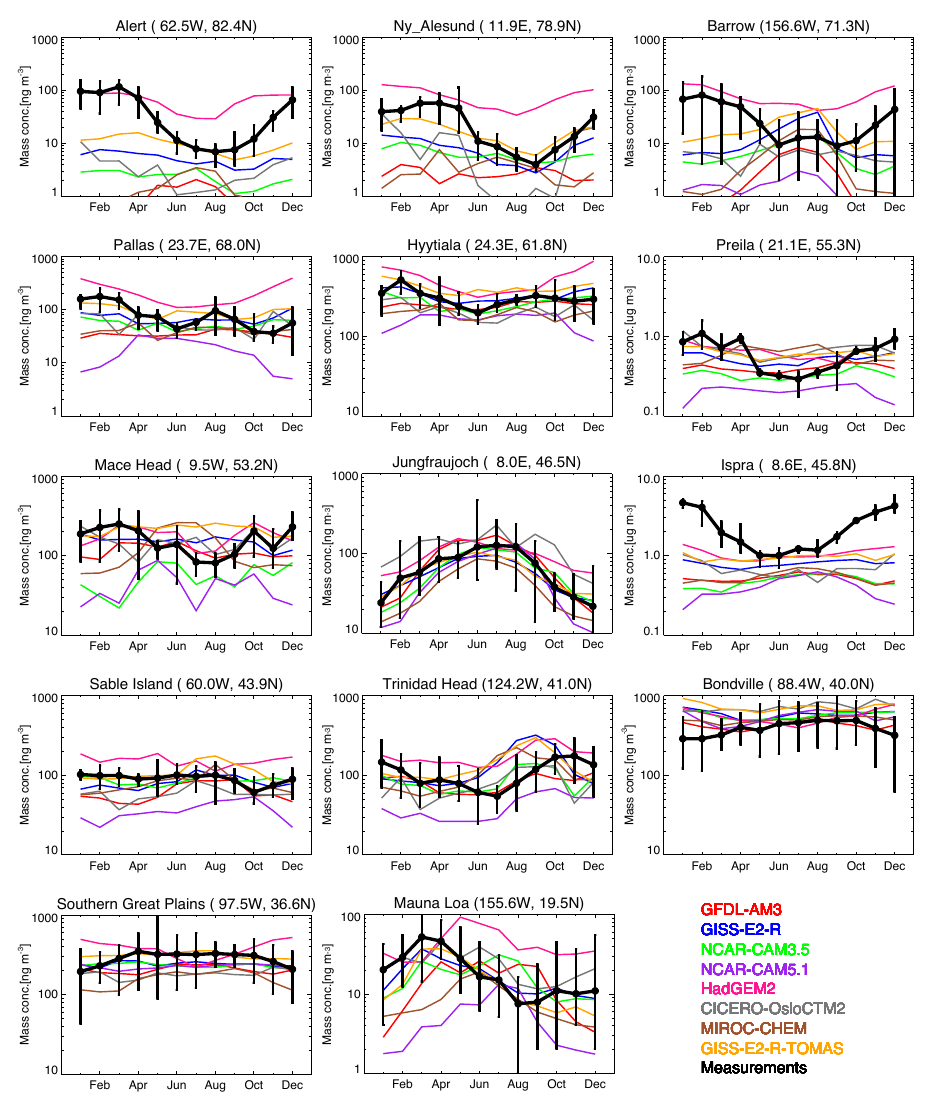
Fig. 7. Seasonal cycle of atmospheric BC surface mass concentrations at the observation sites listed in Table 4. For Jungfraujoch and Mauna Loa, the model BC mass concentration in the vertical layer from approximately 600–700mbar is used to match their high altitude location ( ∼ 3km). Note that the observed BC is shown with the black line with the error bar including the minimum and maximum monthly mean during the observation period. Note that Ny- ˚Alesund and Hyyti¨al¨a are shown as Ny-Alesund and Hyytiala,